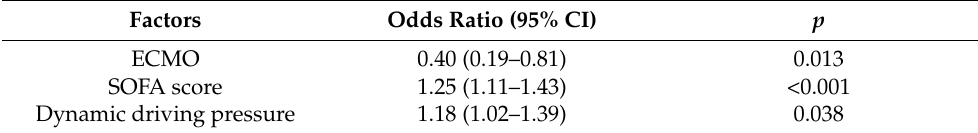
Table 3. Multivariate logistic regression analysis with hospital mortality as outcome.